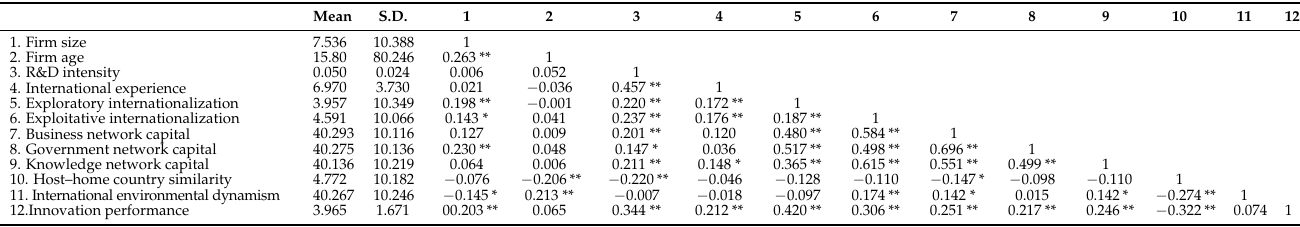
Table 2. Means, standard deviations, and correlations.